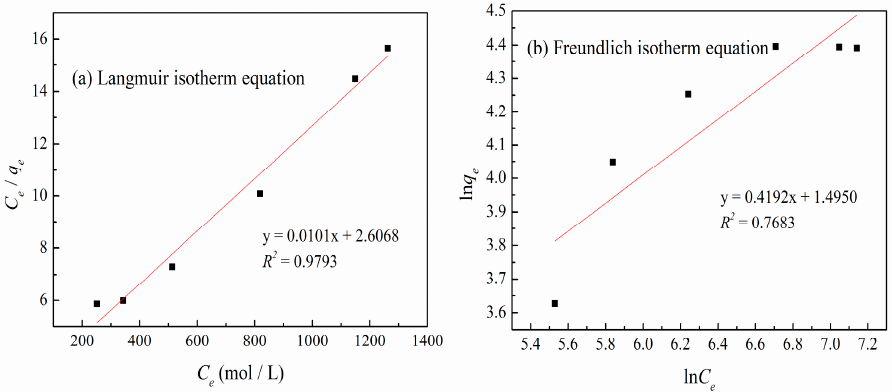
Table 4. Adsorption equilibrium constants obtained from the Langmuir and Freundlich isotherms for zinc(II) adsorption onto XSBLAC. (Adsorption experiment sample dosage: 0.05 g; pH value: 5.2; temperature: 60 °C; adsorption time: 40 min).